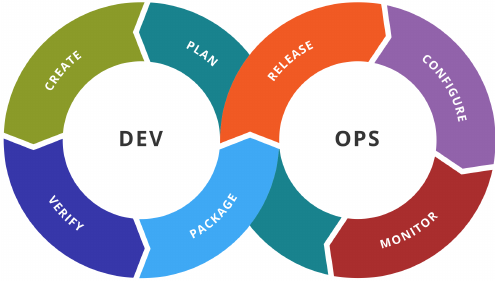
Figure 1. Stages of the general DevOps workflow (source: Khar- nagy via Wikimedia Commons – CC BY-SA